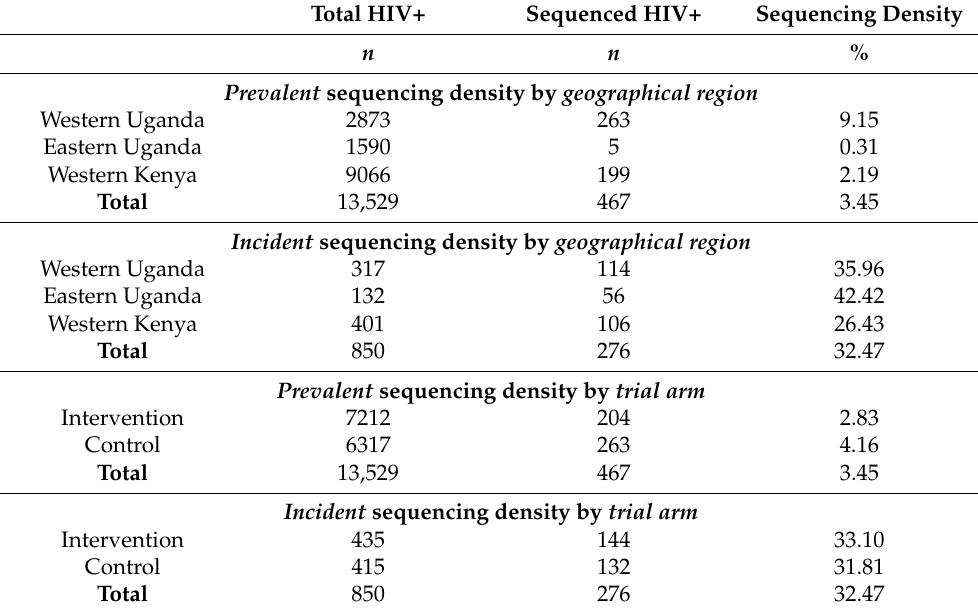
Table 2. Prevalent and incident sequencing densities by geographical region and by trial arm. Total HIV+